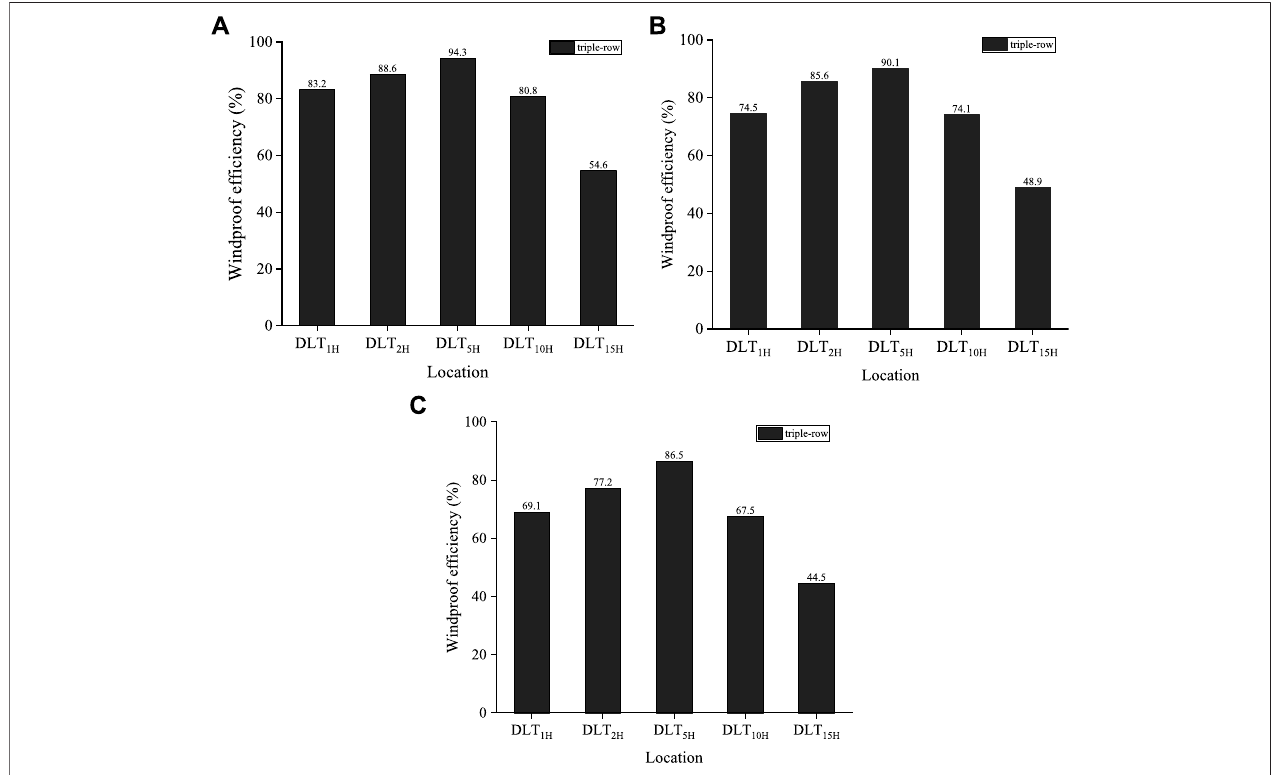
FIGURE 12 | The relationship between windbreak ef fi ciency and forest belt downwind distance under different incoming wind velocities. (A) : V = 8 m · s − 1 , (B) : V = 12 m · s − 1 , (C) : V = 16 m · s − 1 .